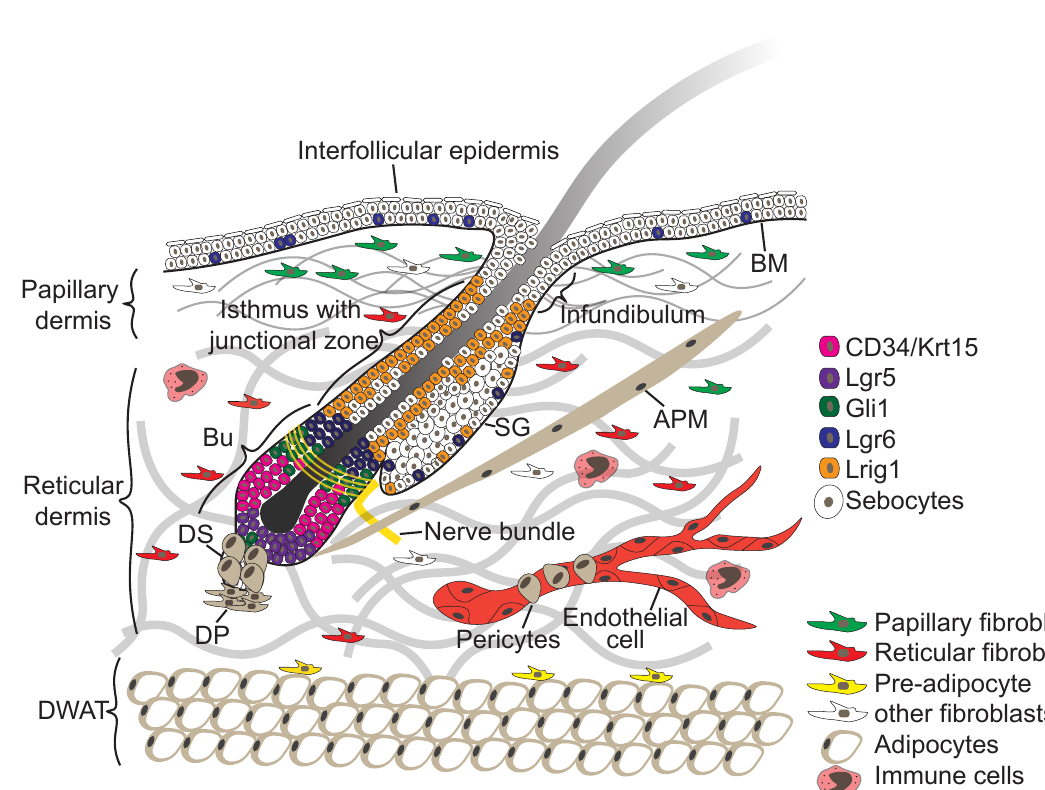
Figure 1. Morphology of the skin. The epidermis and dermis are separated by a BM. In the epidermis, multiple spatially distinct stem cell populations have been identified in the hair follicle bulge, isthmus and sebaceous gland, and their characteristic markers are shown in the colour coded legend. In the dermis, papillary fibroblasts are located in proximity to the BM and are embedded in thin collagen fibres. Reticular fibroblasts populate the central dermis and are surrounded by thick collagen bundles (grey). Preadipocytes are close to the DWAT where the mature adipocytes reside. In addition, specialised fibroblast subpopulations associate with the HF give rise to the DP, DS and APM. Endothelial cells form the blood vessels which are surrounded by pericytes. Sensory neurons are associated with the HF upper bulge SC population and di ff erent immune cell types populate di ff erent regions of the